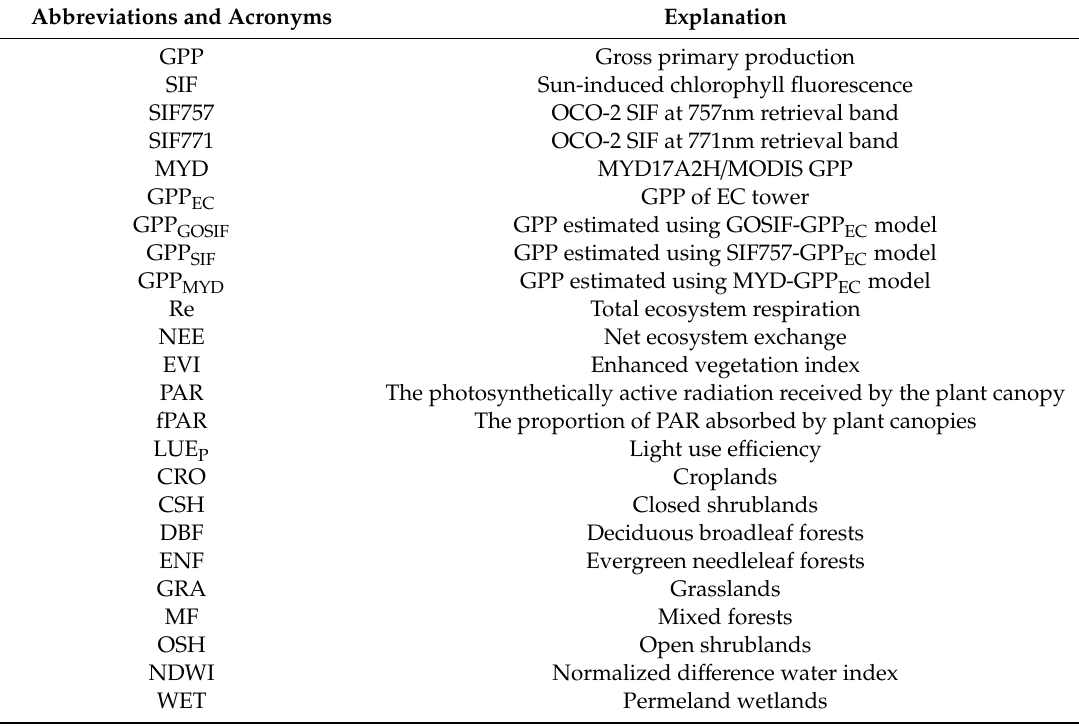
Table 3. Explanation of Abbreviations and